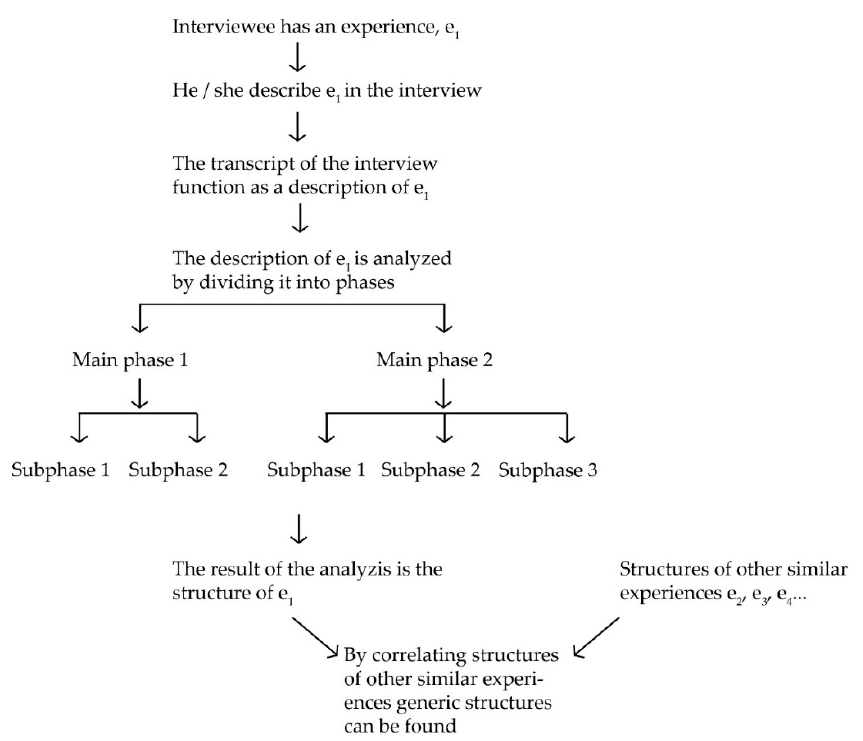
Figure 2. The unfolding of generic structures of experience with the micro-phenomenological